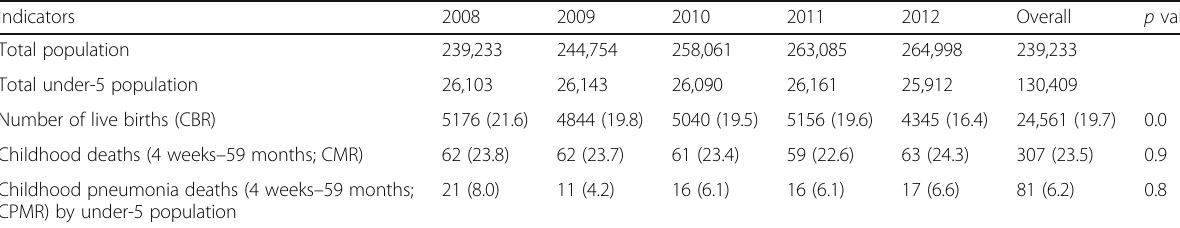
Table 1 Fertility and mortality indicators of rural Mirzapur DSS, 2008 – 2012